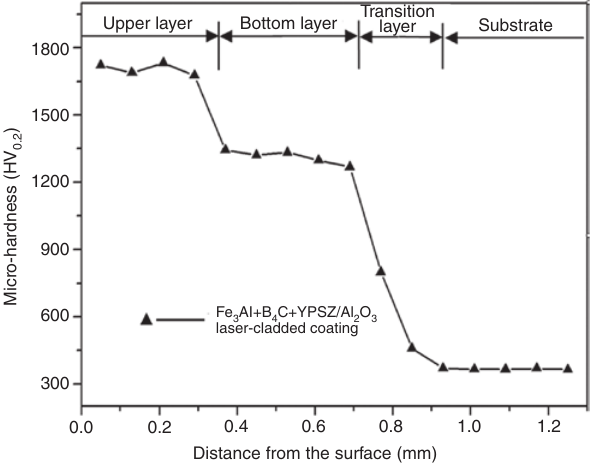
Al-B C-YPSZ-Al O 3 4 2 3